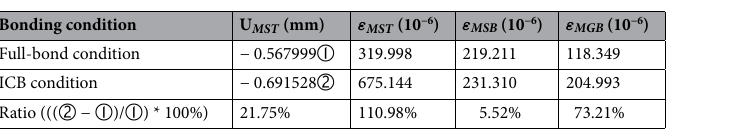
Table 2. Responses under different interface condition.